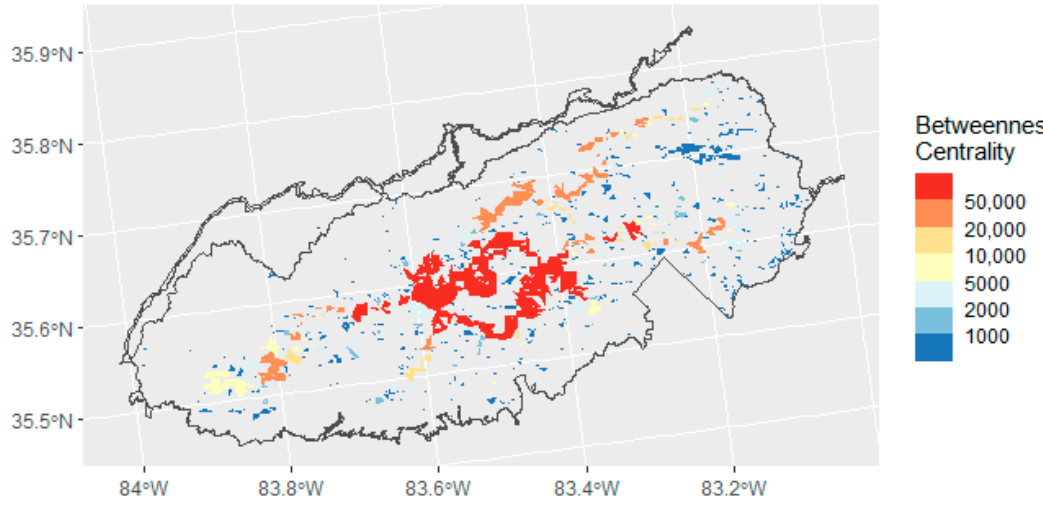
Figure 8. Betweenness centrality of patches dominated by SOD spreader species in the Great Smoky Mountains National Park. Mountains National Park .